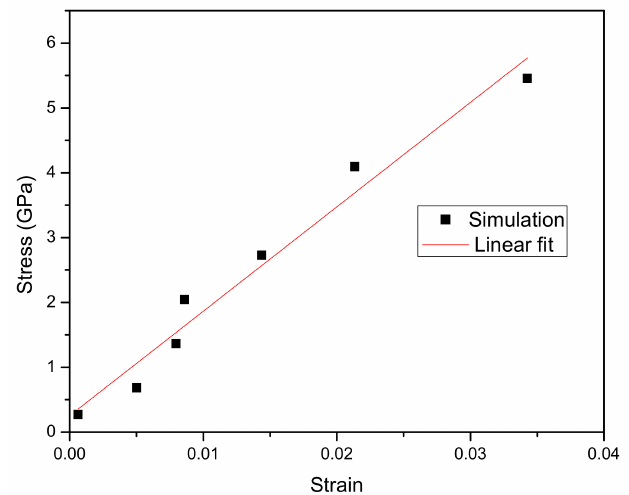
Figure 10. Stress-strain